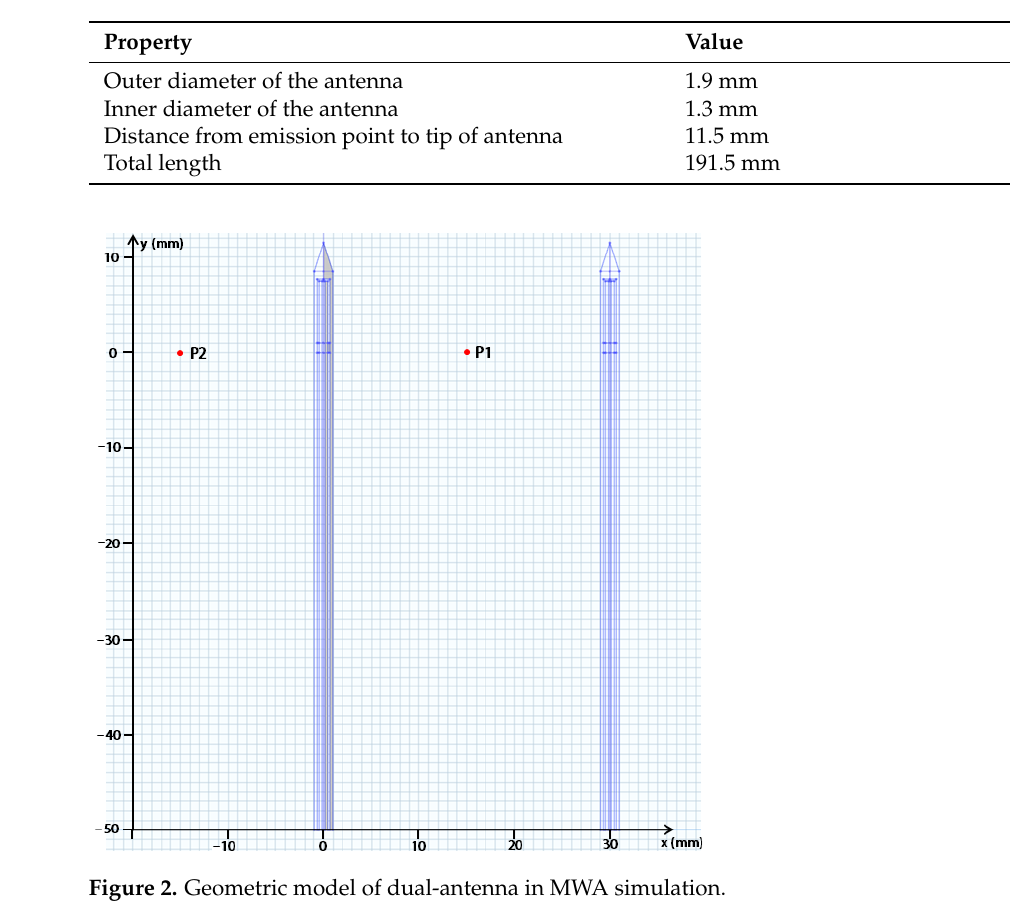
Table 1. Dimensions of the 2.45 GHz microwave antenna.